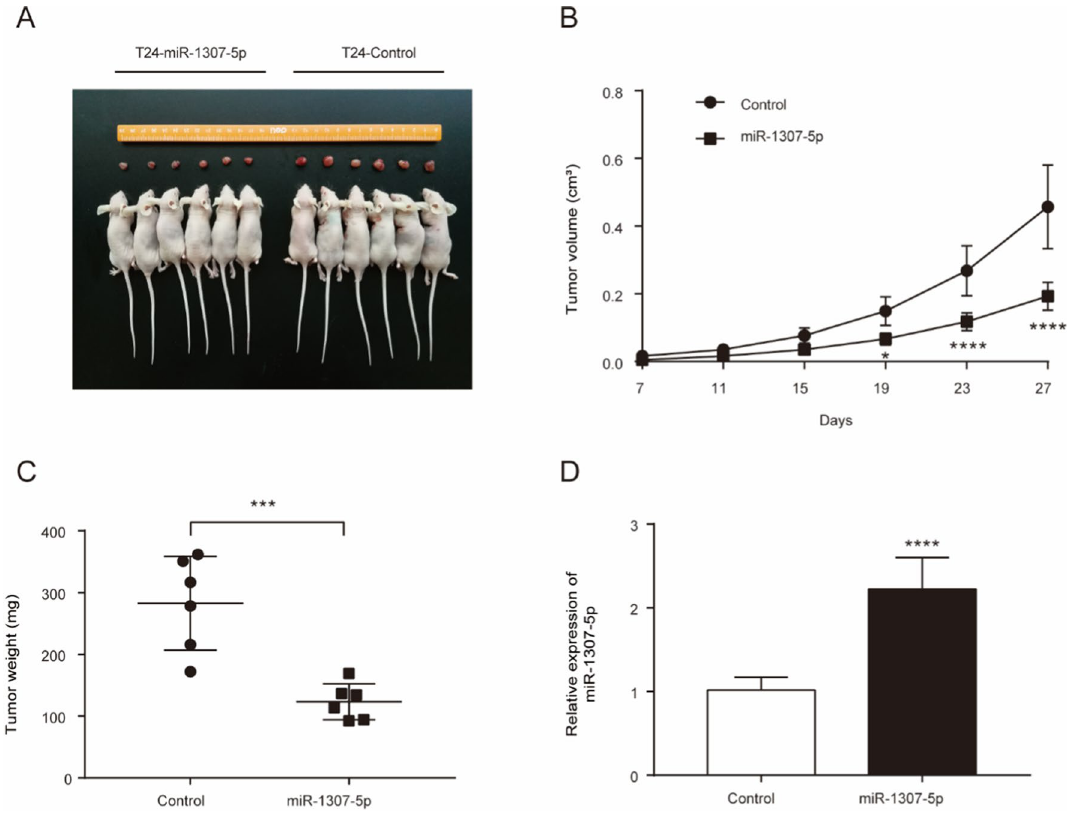
Fig. 3 miR-1307-5p inhibits bladder cancer growth in a xenograft nude mice model. A Macrograph of tumors in all groups. B Calculated tumor volume. C Calculated tumor weight. D Expression of miR-1307-5p as determined by RT–qPCR. *p < 0.05; ***p < 0.001; ****p < 0.0001. Data depicts the mean ± standard deviation and are representative of three independent